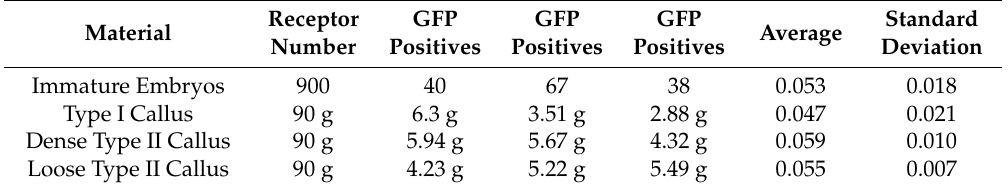
Table 1. The instantaneous conversion efficiency in different types of receptor materials in three repeats. Material